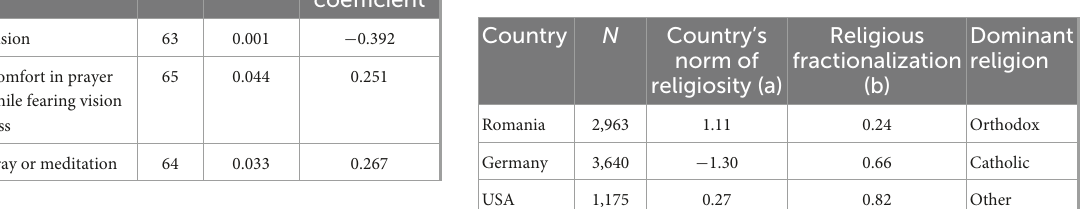
TABLE 12 Country-wise descriptive statistics of the social norm of